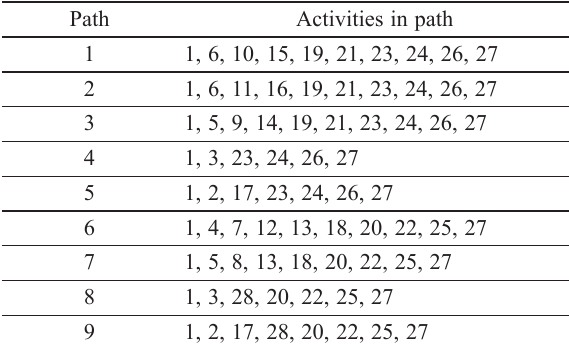
Table 3. Paths of activity network for the example